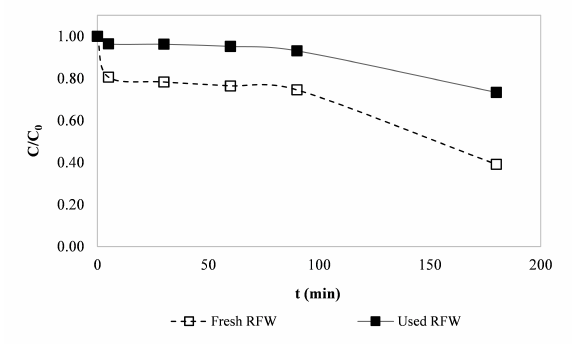
Fig. 6. Effect of pH and Contribution of leached iron (RFW=0.75 g/L; H 2 O 2 =6.6 mM; MO=50 mg/L; T=30 ◦ C)